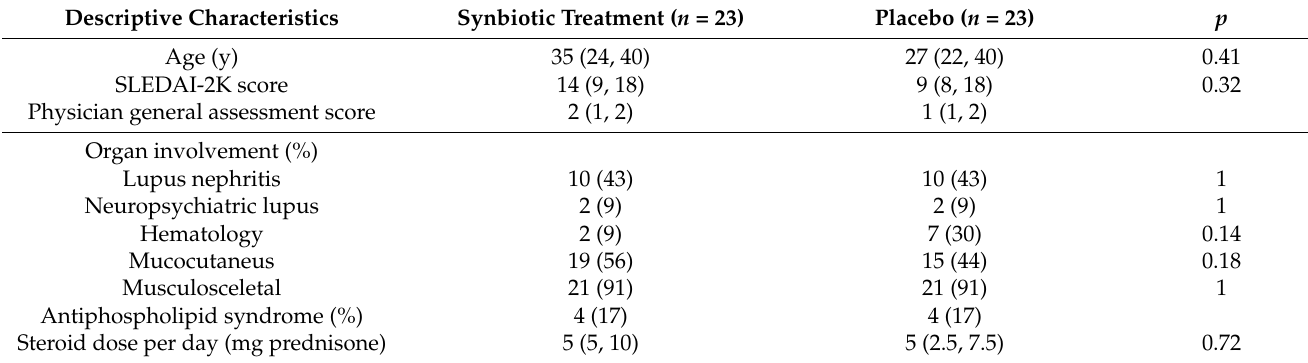
Table 1. Baseline